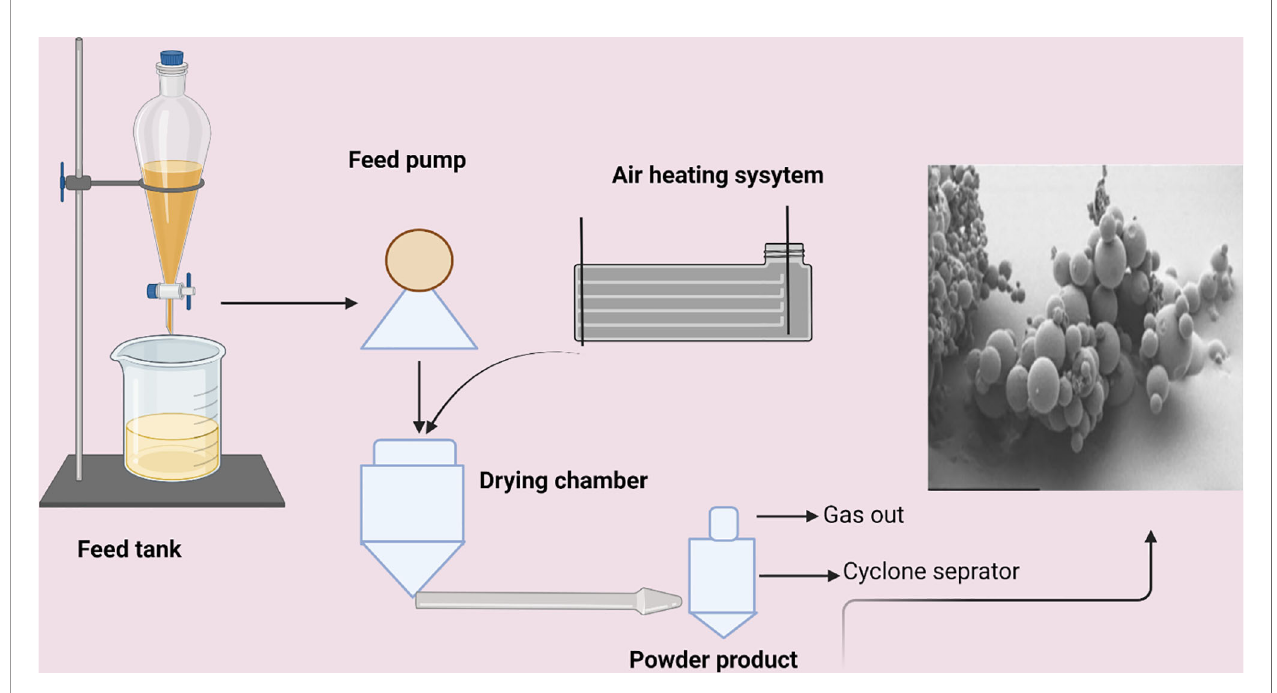
FIGURE 4 | Representation of the spray-drying